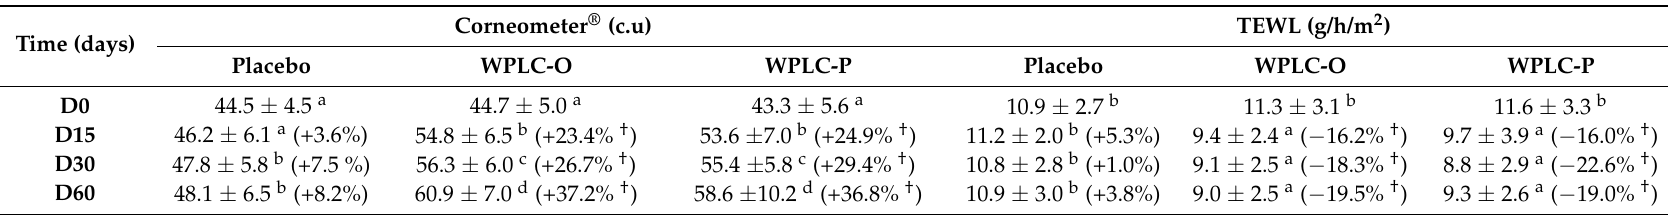
Table 6. Skin Hydration and TEWL results after 15, 30 and 60 days of supplementation with WPLC-O and WPLC-P extracts measured by Corneometry ® and Tewameter ® . Data are averages ± SD in corneometric units (c.u.) and in TEWL (g/h/m 2